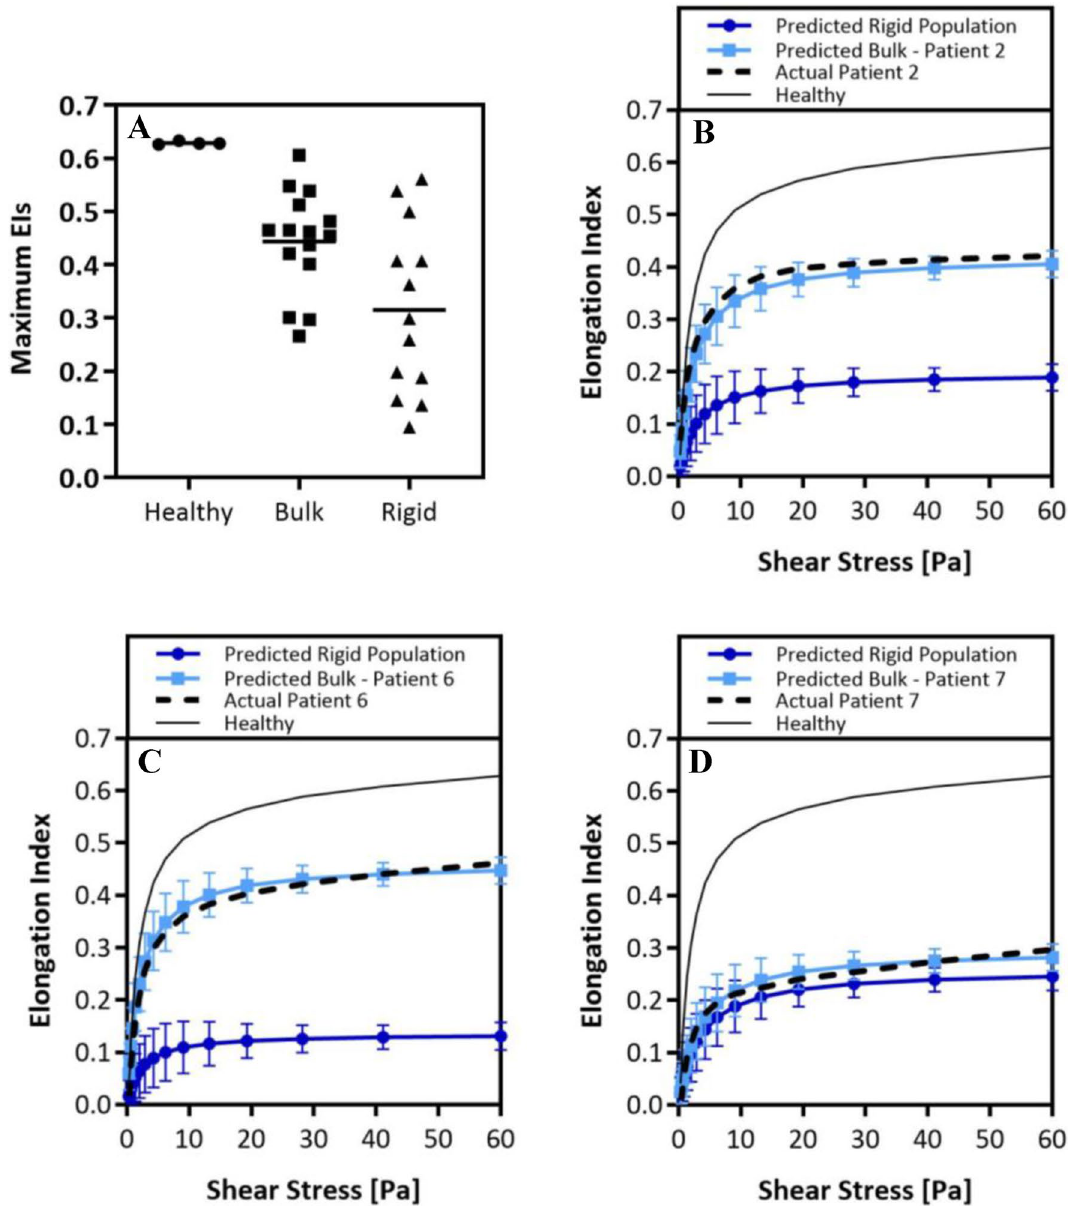
Figure 2. Predicting the rigidity of the rigid RBC populations in sickle-cell disease patients. ( A ), Average maximum EIs of healthy donors, actual bulk patient measured maximum EIs, and predicted maximum EIs of rigid population. Actual healthy and patient ektacytometry curves compared with predicted patient bulk ektacytometry curve and predicted curve of the rigid RBC population: ( B ), patient 2. ( C ), patient 6. ( D ), patient 7. Error analysis of the predicted EIs as a function of shear was performed using least square difference analysis. Error bars are plotted as standard deviation of the predicted elongation values. Student’s t-tests are performed to determine significance between Actual Patient curves and Predicted Bulk Curves, no significant difference is found for any patient using an α = 0.05, p-values >